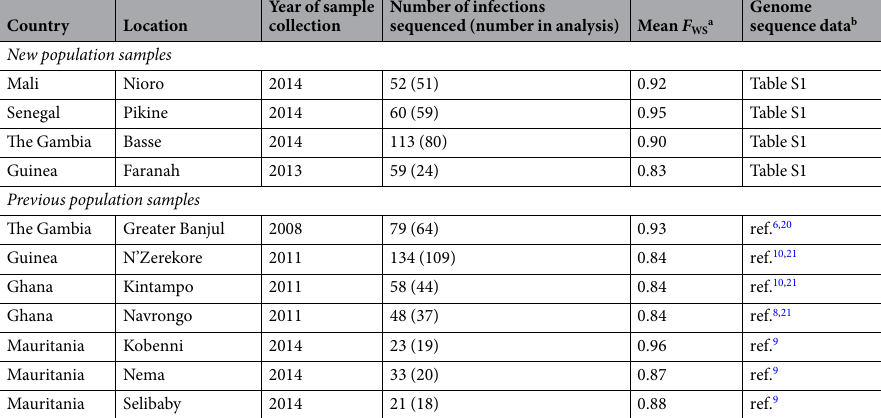
Table 1. Sequenced population samples of Plasmodium falciparum from four West African locations and previous data incorporated into a multi-population analysis across the region. a F WS values (within-infection genotypic fixation indices) are given for individual infection samples in Table S1 and Fig. 2. b Sequence accession